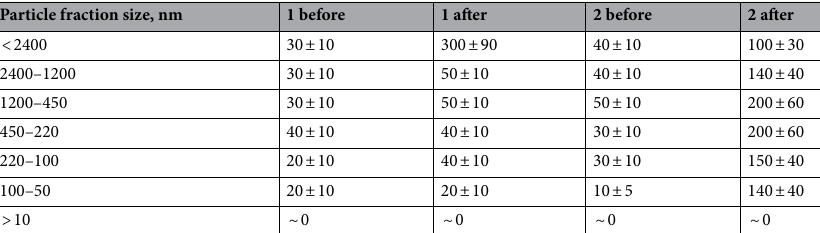
Table 2. The intensity of light scattering (kHz) by suspended particles of different fractions before and after day 30 of the ongoing microbial process in the stratal water (Light scattering intensity was determined by Zetasizer Nano ZS, Malvern